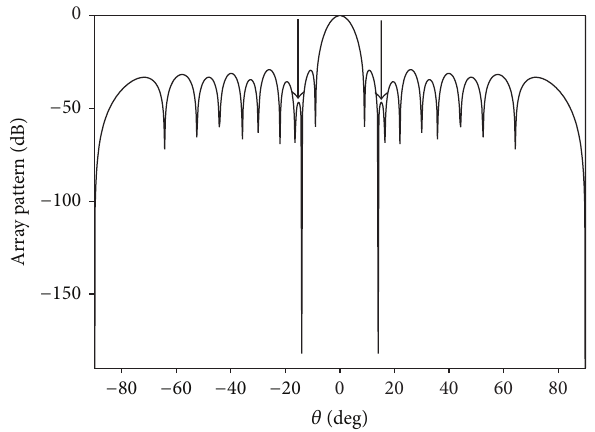
Figure 8: Radiation pattern achieved by controlling the amplitude only with a wide null sector centered 30 ∘ with Δ𝜃 = 5 ∘